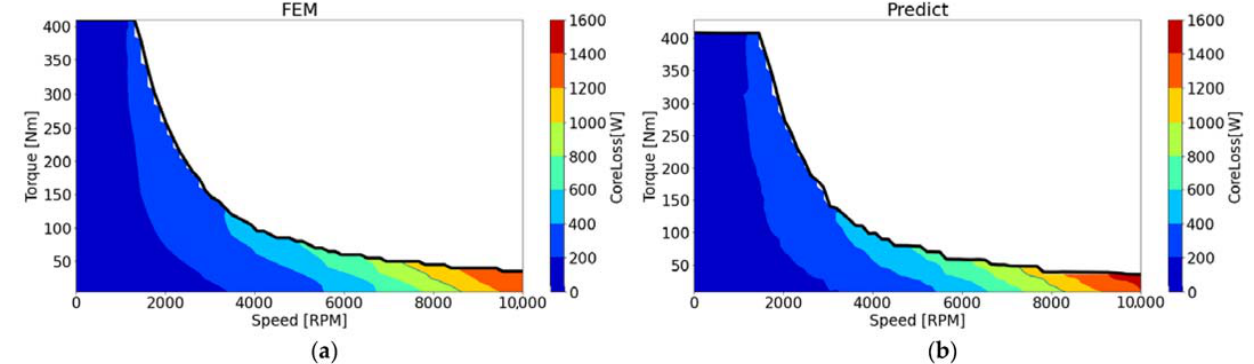
14 of 19 Figure 7. Analyzed motor torque: ( a ) torque ‐ current angle; ( b ) torque ‐ speed map. Figure 8. Analyzed motor efficiency: ( a ) 2D FEM; ( b ) proposed method.